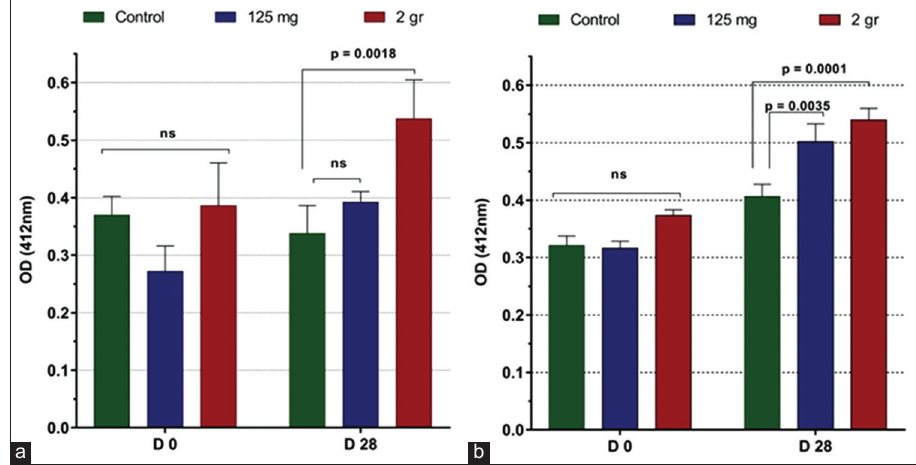
Figure-1: Horse serum (a) alternative and (b) classical complement pathway activation on chicken erythrocytes. Data are expressed as the optical density (OD ) mean±SEM (n=6) obtained from the supernatant of lysed erythrocytes. 412 nm Supernatant from 100% hemolysis had an OD of 0.750. Significant differences among treatment are indicated 412